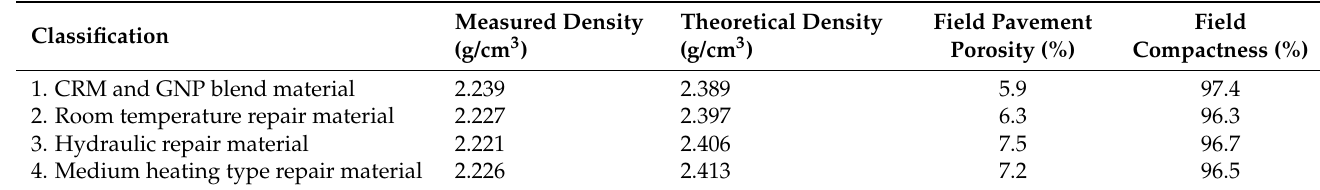
Table 7. Porosity and compactness of field test construction sections.